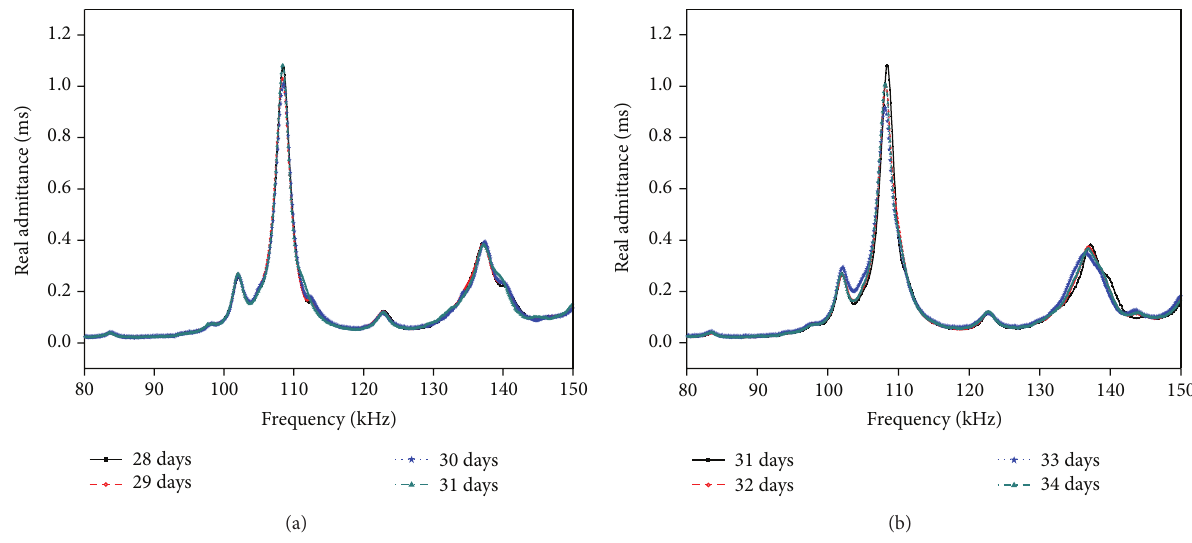
Figure 5: Real admittance curves of PZT impedance sensors encapsulated by using cement material: (a) 28–31 days and (b) 31–34 days.